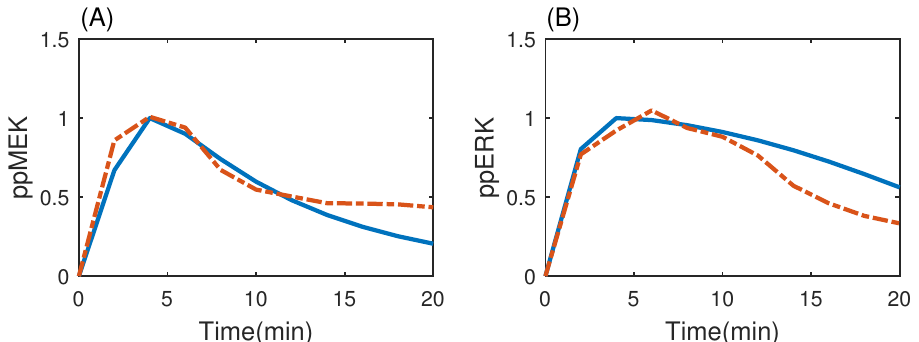
Figure 6. Comparison of experimental data and simulation using the estimated model parameters for the MAP kinase pathway. ( A ) ppMEK. ( B ) ppERK (solid-line: simulation, dash-dot-line: experimental data). Table 1. Estimated model parameters for the MAP kinase pathway. Estimated value: the estimated value for each parameter. STD: standard deviation of the 100 estimates in the final